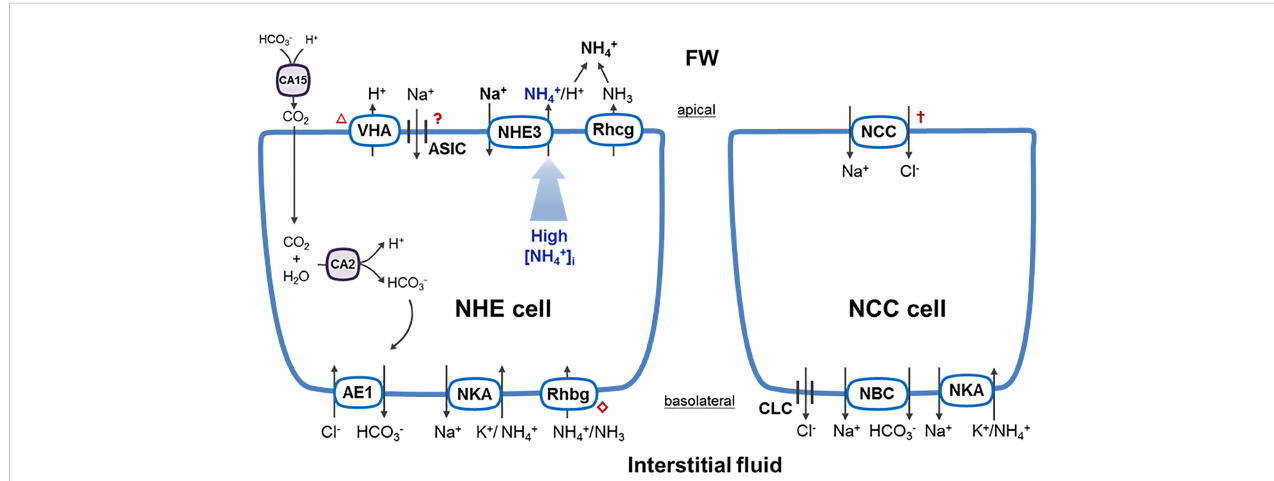
FIGURE 1 General model of ionocytes for teleost Na + uptake. Details refer to the text. AE1, anion exchanger 1; ASIC, acid-sensing ion channel; CA15, membrane- bound carbonic anhydrase 15; CA2, cytosolic carbonic anhydrase 2; CLC, Cl - channel; NBC, Na + -HCO 3- co-transporter; NCC, Na + -Cl - co-transporter; NCC cell, NCC-expressing ionocyte; NHE3, Na + /H + exchanger 3; NHE cell, NHE3-expressing ionocyte; NKA, Na + /K + -ATPase; Rhbg, rhesus B glycoprotein; Rhcg, rhesus C glycoprotein; VHA, vacuolar-type H + -ATPase; question mark (?), uptake function with controversial evidence; triangle mark ( △ ), apical localization only in zebra fi sh and limited species; cross mark ( ✝ ), unclear driving force for NCC. Rhombus mark ( ⋄ ), transporter expressed in ionocytes or in pavement cells/keratinocytes (Nakada et al., 2007; Wu et al., 2010; Shih et al., 2013). Model size does not represent a relative cell size for NHE and NCC